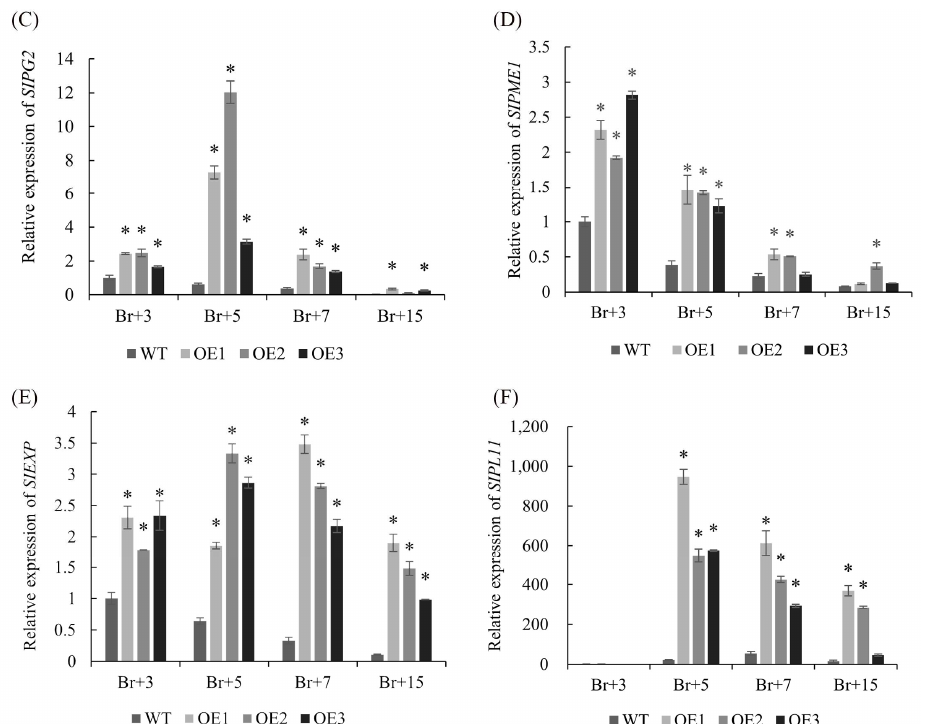
Figure 7. Overexpression of VvPL11 affected pectin degradation and the expression levels of pectin- related genes in tomato. ( A ) Propectin; ( B ) WSP; ( C ) SlPG2 ; ( D ) SlPME1 ; ( E ) SlEXP ; and ( F ) SlPL11. (* p < 0.05, Student’s t -test). Data were shown as the means ± standard deviation. * represent significant differences at p < 0.05.